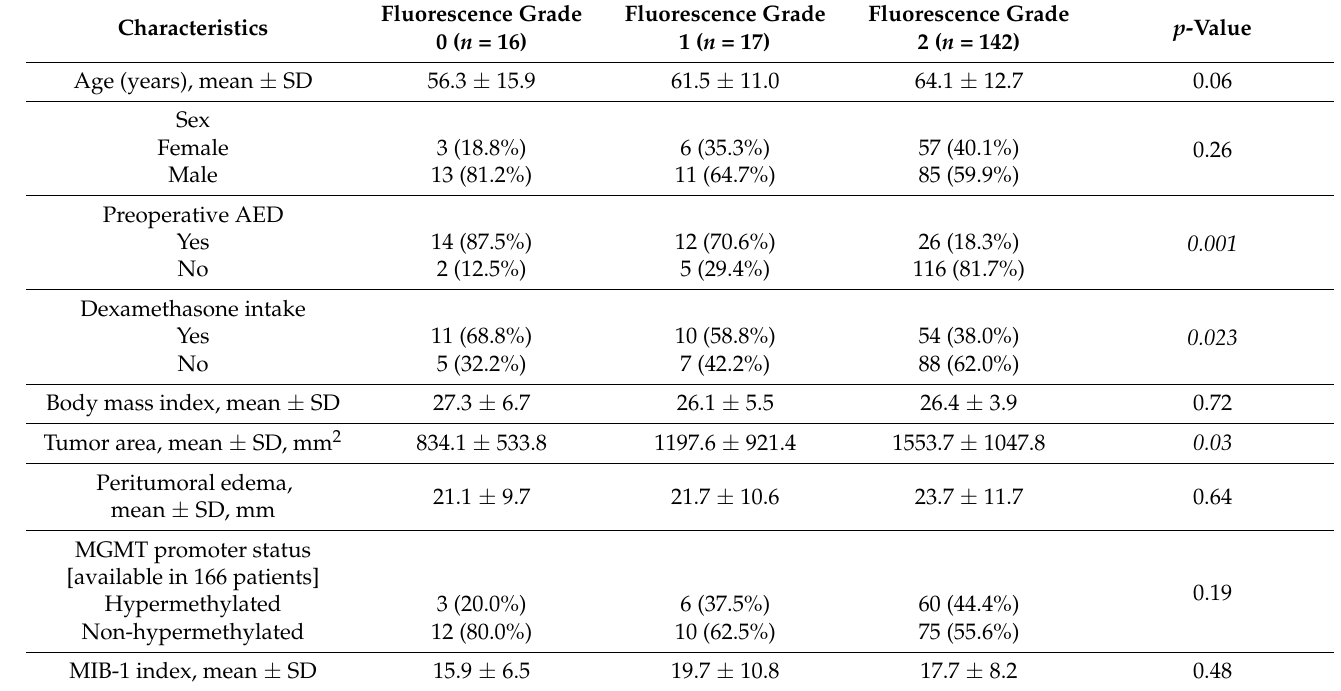
Table 2. Comparison of patient characteristics among fluorescence quality grades (using Fisher’s exact test (two-sided) and